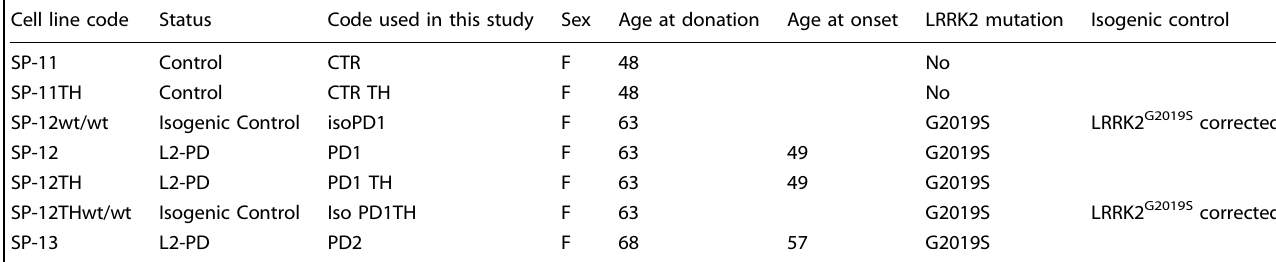
Table 1. Summary of the healthy controls and patients used in this study. Cell line